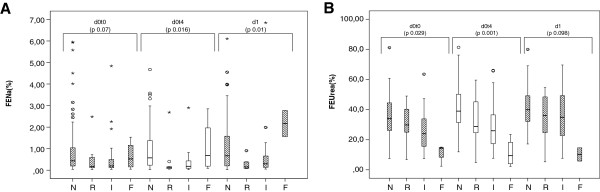
FENa(%) and FEUrea(%) at the different time points in AKIuo. (A) U-shaped form of FENa over the different AKIuo classes (N, no AKI; R, Risk; I, Injury; and F, Failure; (P = 0.07, 0.016, and 0.01 at d0t0, d0t4, and d1, respectively). (B) Decreasing trend in FEUrea(%) across AKIuo classes at the different time points with persistently low FEUrea(%) in RIFLE F class at the three time points (P = 0.029; P = 0.001; and P = 0.098).